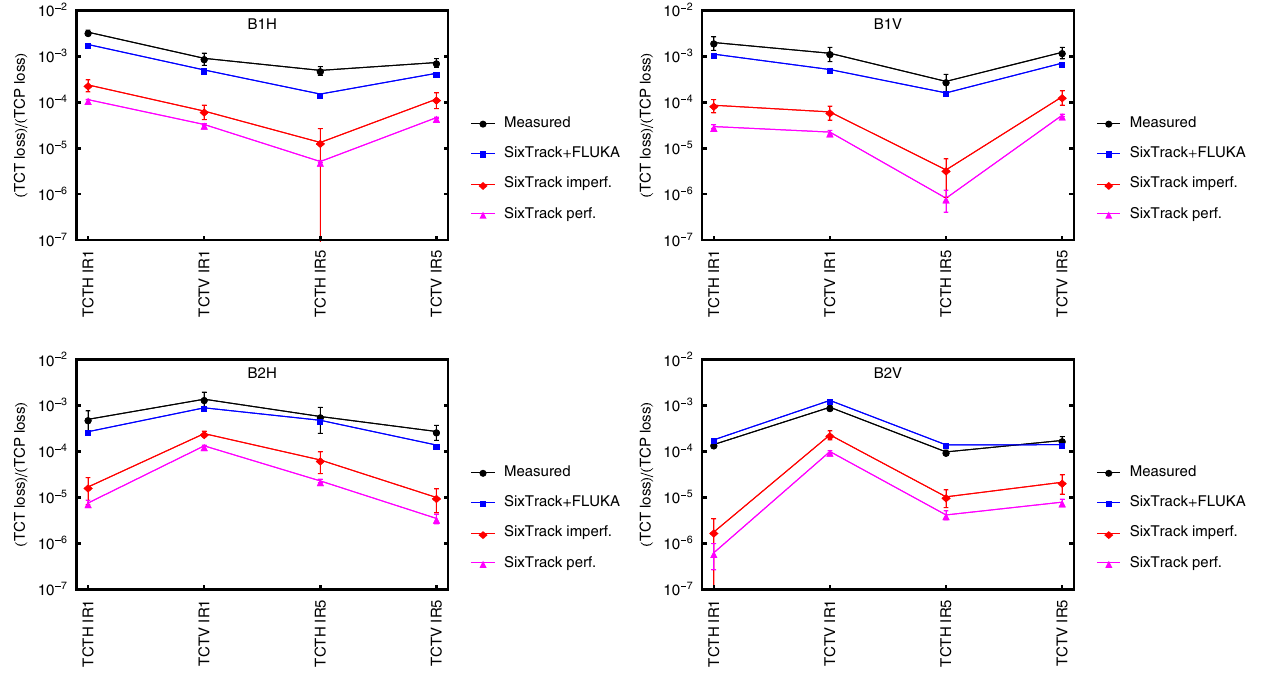
FIG. 15. The ratio of BLM signal, or particles lost, on horizontal and vertical TCTs to the TCPs in simulations and measurements in the 2011 machine. Simulation results are shown both from counting primary losses in SixTrack, as well as with a two-step simulation where FLUKA simulates the shower to the BLMs, starting from the SixTrack impacts in the simulations including imperfections. The errors on the SixTrack simulations indicate the standard deviation over different random seeds with